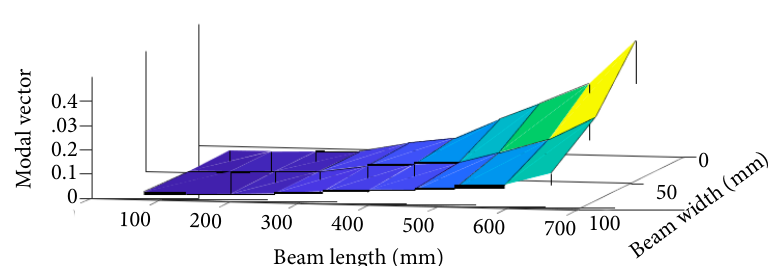
Figure 8. Second mode shape experimentally